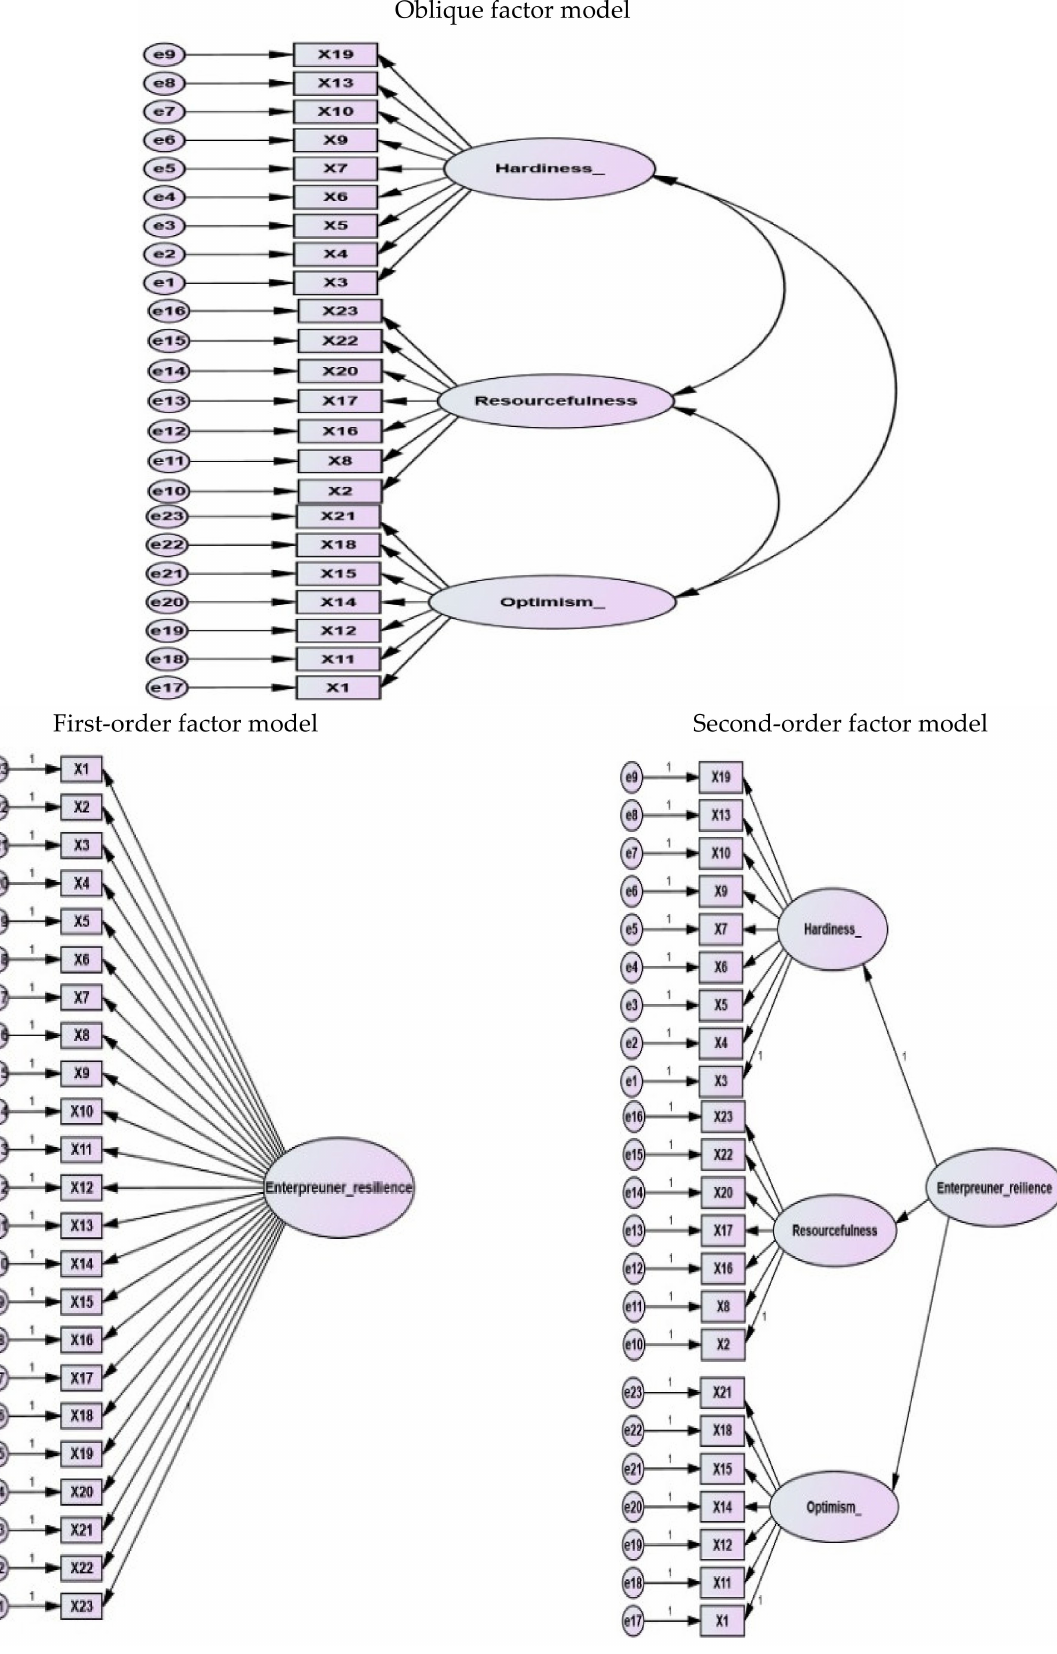
Figure 2. Three alternative